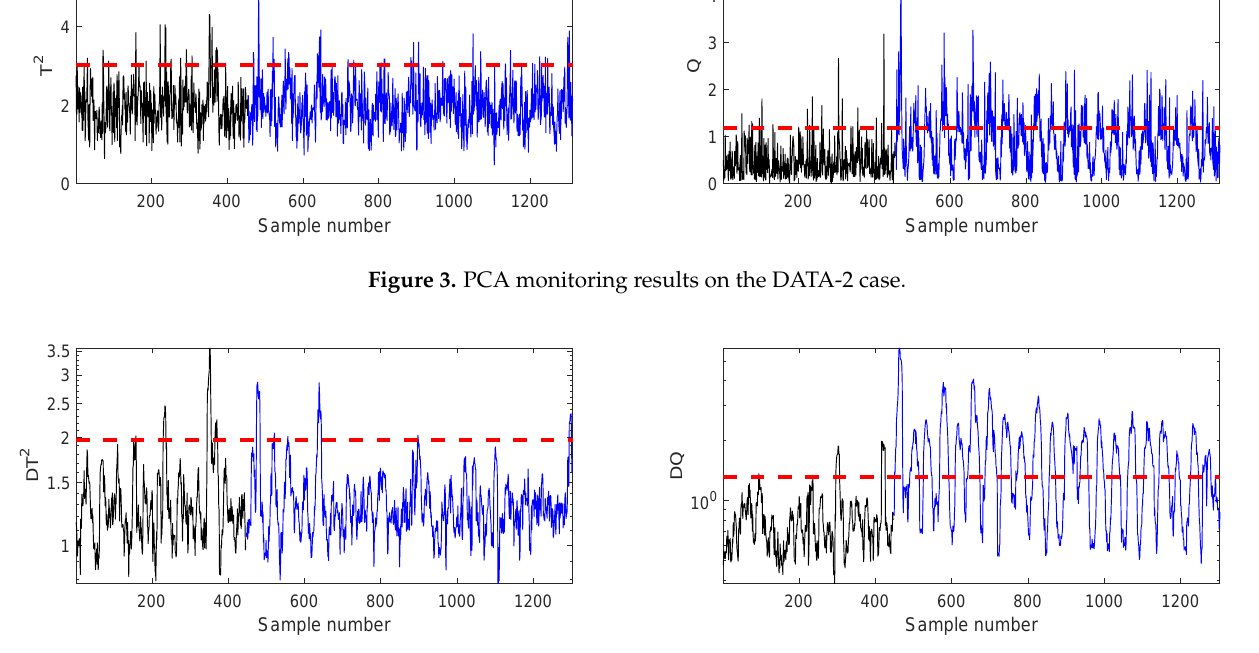
Figure 4. PCA k NN monitoring results on the DATA-2